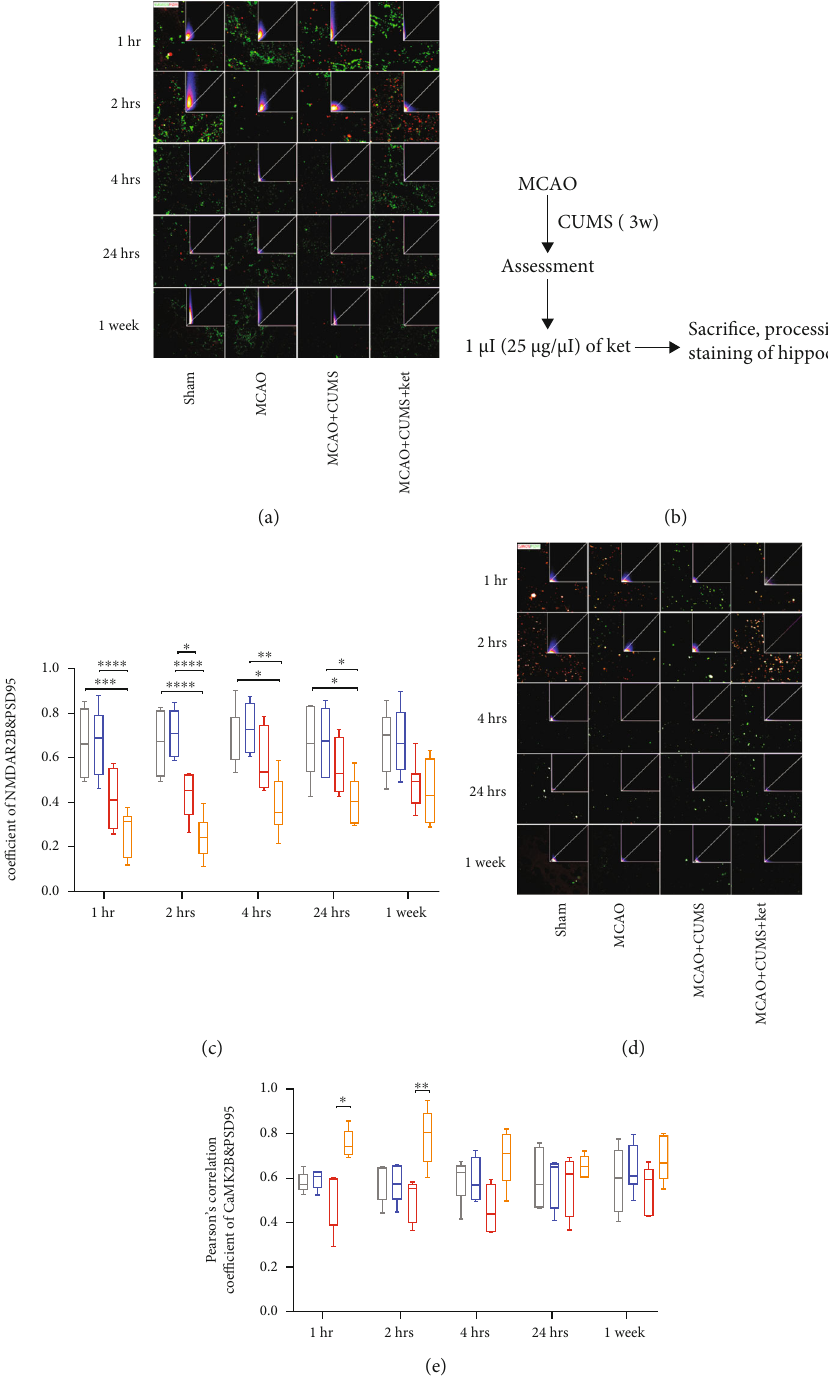
Figure 4: Analysis of the relationship between the NMDAR/CaMKII pathway and changes at the postsynaptic level by colocalization. (a) Representative confocal images of the relationship between NR2B (labeled in green) and PSD95 (labeled in red). The upper right corner of each image shows the corresponding scattergram with pixel concentration along the diagonal, depending on the degree of colocalization. (b) Schedule and procedures before image acquisition. (c) Colocalization between NR2B and PSD95, as analyzed by Pearson ’ s correlation coe ffi cients. (d) Representative confocal images of the relationship between CaMK2B (labeled in red) and PSD95 (labeled in green). The upper right corner of each image shows the corresponding scattergram with pixel concentration along the diagonal, depending on the degree of co-localization. (e) Colocalization between CaMK2B and PSD95, as analyzed by Pearson ’ s correlation coe ffi cients. Scale bar: 20 μ m. Pearson ’ s correlation coe ffi cient analysis was based on ten sight fi elds in each group. n = 6 per group. 1 hr: 1hour, 2hrs: 2 hours, 4hrs: 4 hours, 24 hrs: 24 hours, and 3 w: 3 weeks. ∗ p < 0 : 05 , ∗∗ p < 0 : 005 , ∗∗∗ p < 0 : 0005 , and ∗∗∗∗ p < 0 : 0001